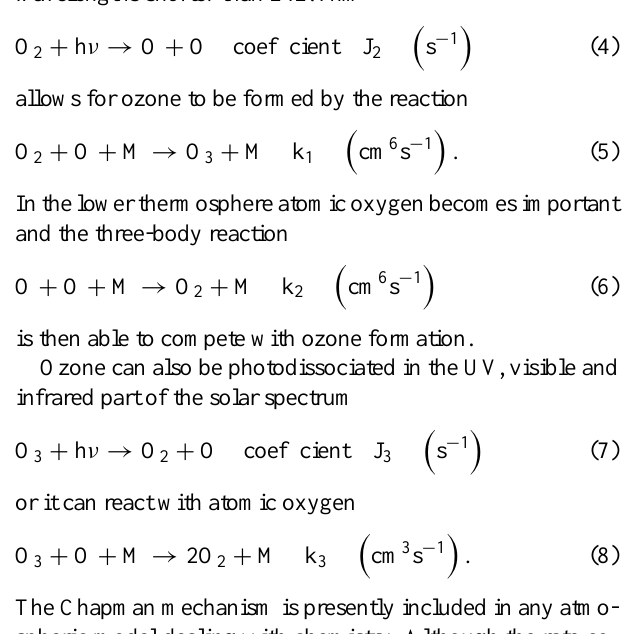
Fig. 7. Photodissociation cross section for O 2 and O 3 .